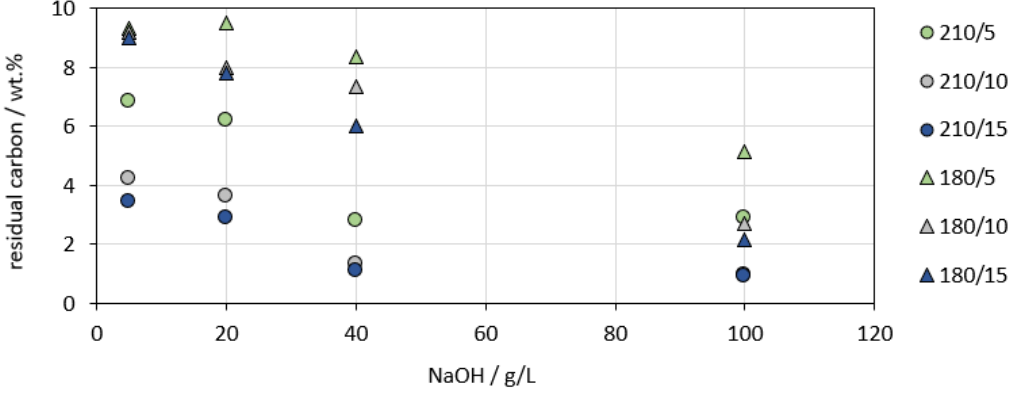
Figure 8. The difference in the pH and calculated consumption of OH − at 180 °C/series A2 ( a ) and 210 °C/series A1 ( b ); constants: 1 h, 800 rpm, S/L: 0.1; caption horizontal axis: NaOH conc./oxygen pressure.